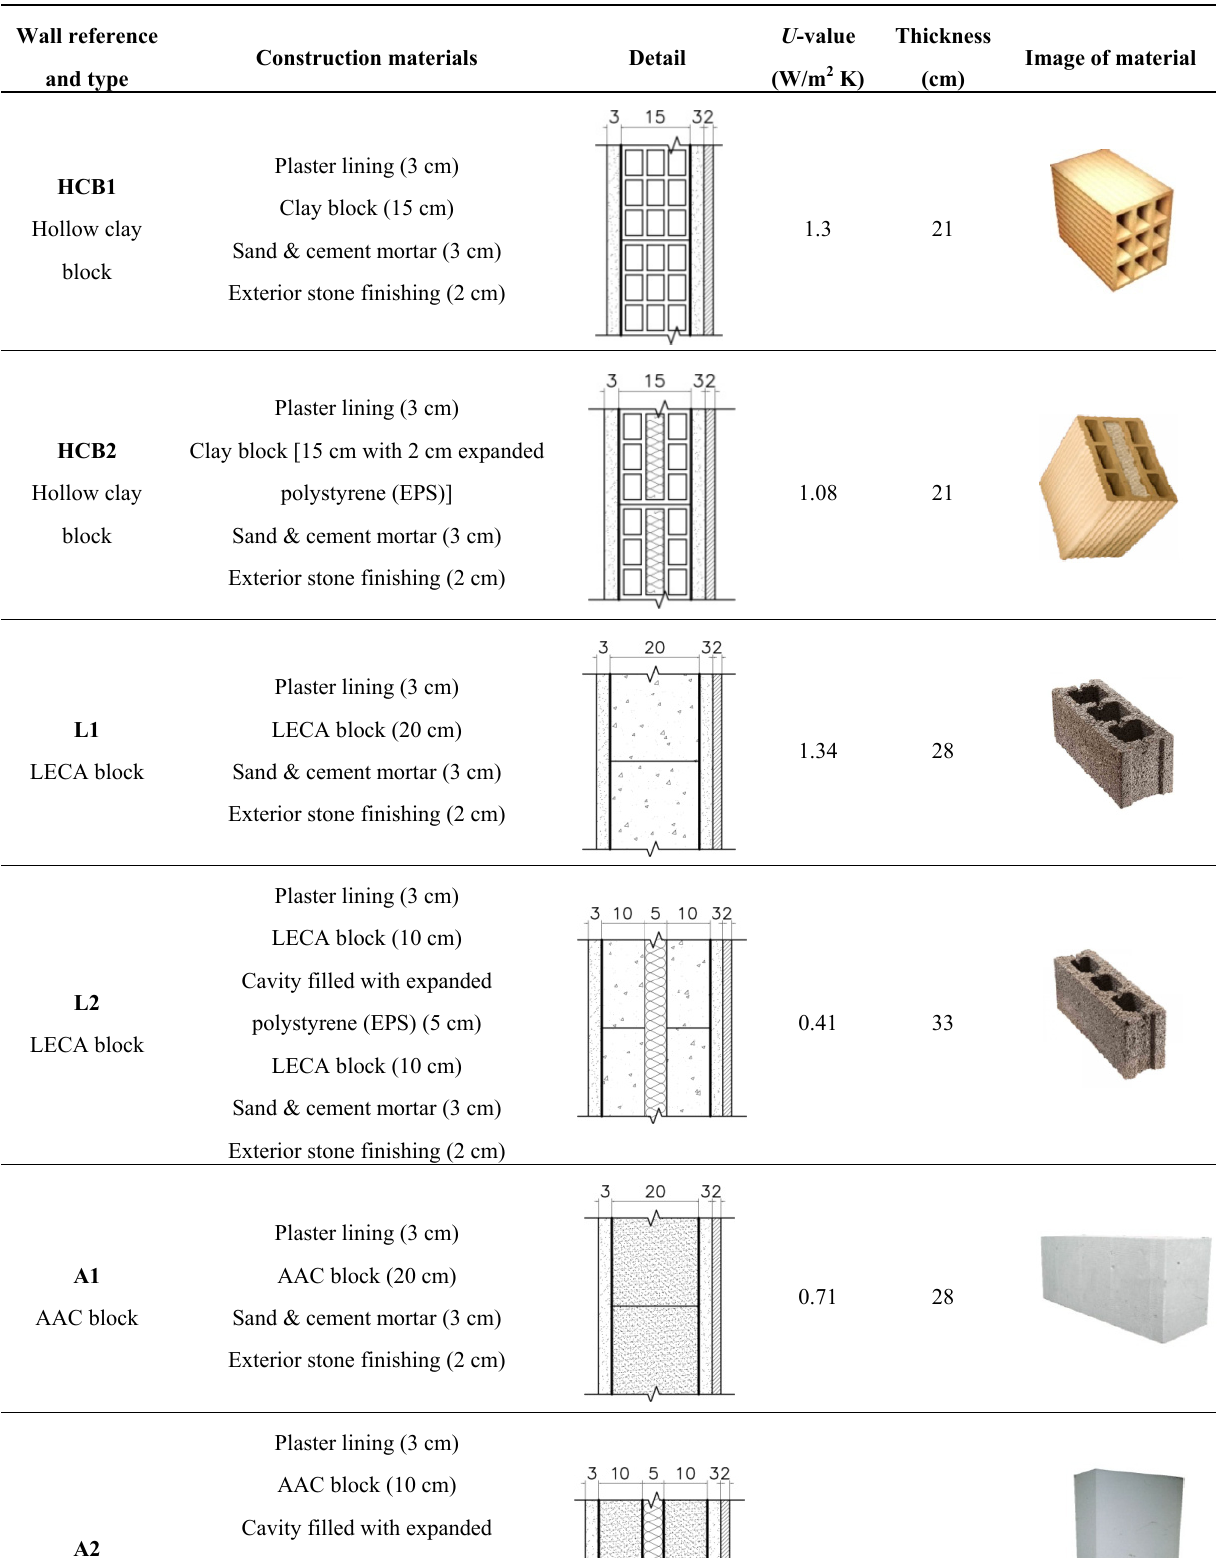
Table 2. Categorization of conventional wall